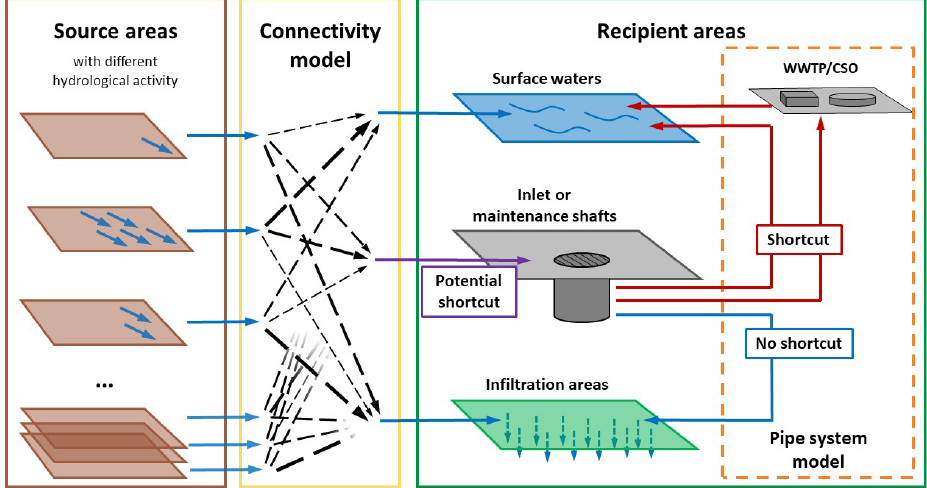
Figure 2. Structure of the surface runoff connectivity model. WWTPs – wastewater treatment plants; CSO – combined sewer overflow.